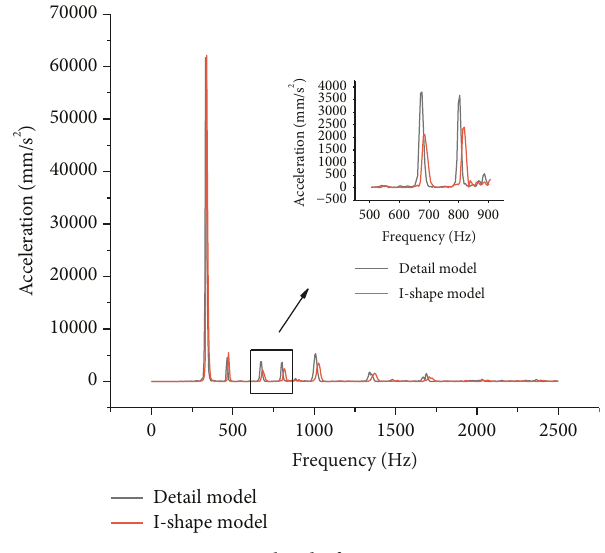
Figure 13: Amplitude-frequency curve.